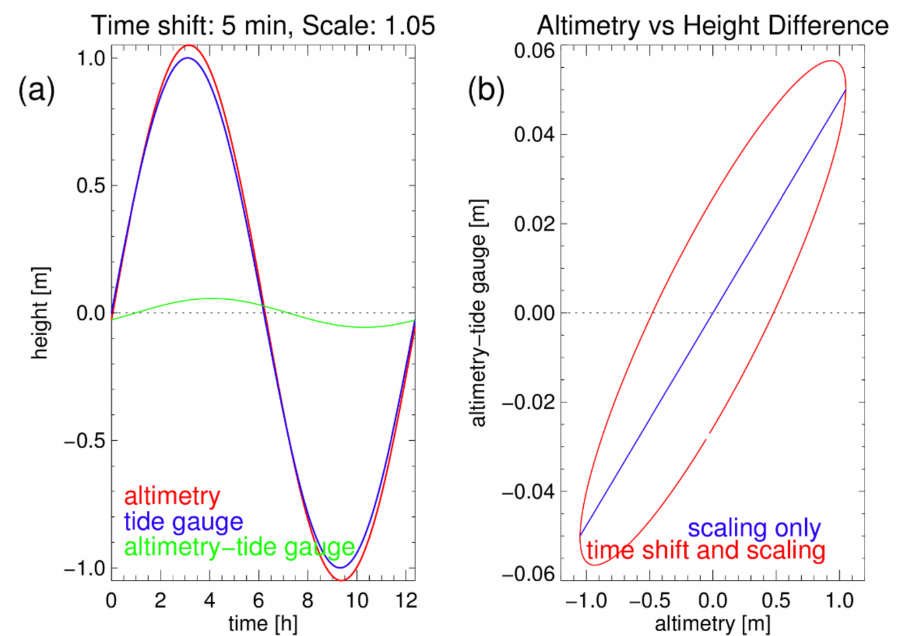
Figure 4. Sketch showing ( a ) two idealized M 2 sea-level series with a slightly different phase (5 min offset) and amplitude (1 m/1.05 m), and ( b ) the difference between the two series in dependence on the sea level for amplitude scaling (blue) and amplitude scaling plus time shift (red).